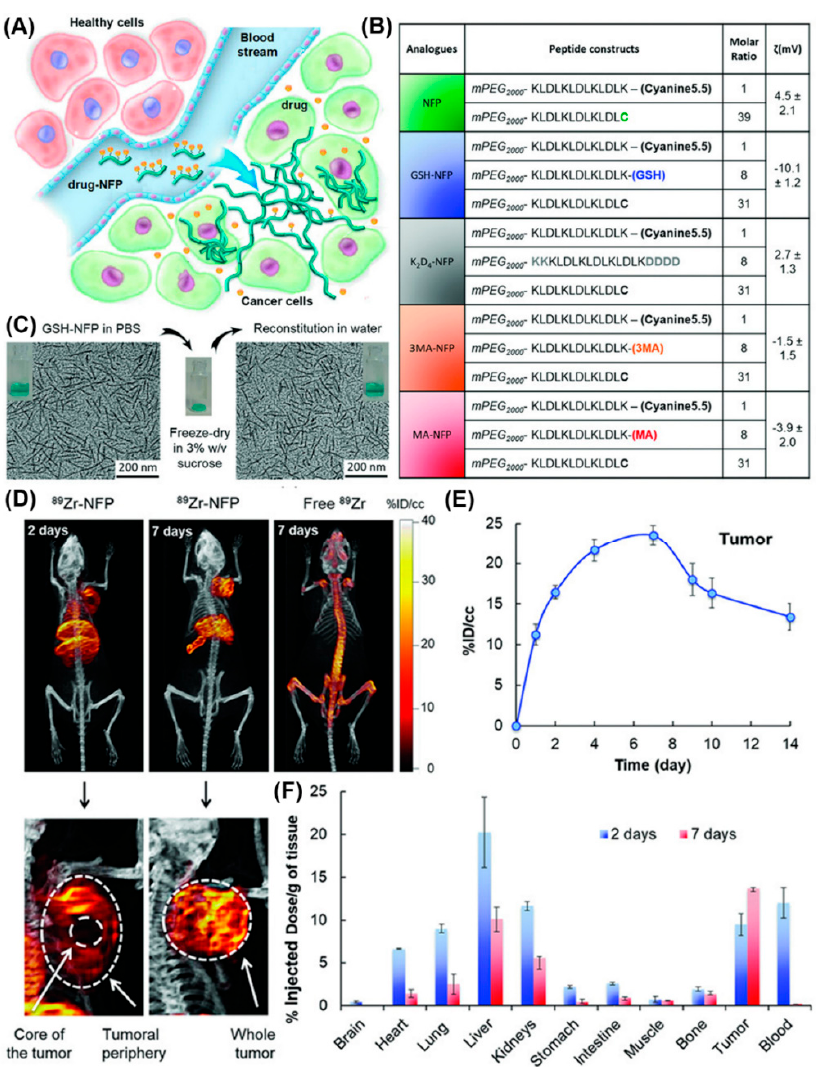
Figure 19. ( A ) Design of NFP analogues to improve tumoral uptake, penetration, and local retention. ( B ) A table showing NFP analogue composition and surface charge. ( C ) Morphologies of GSH-NFP in PBS buffer (left) before freeze-drying in sucrose and after reconstitution in water (right). ( D ) Representative PET/CT whole body images of SCID mice bearing MDA-MB-468 tumors were acquired 2 and 7 days after injection. ( E ) Quantification of nanofibers (radioactivity) at the region of interest (ROI; tumor) was plotted to reveal the kinetic uptake and the retention properties of GSH-NFP at tumor sites. ( F ) The biodistribution of 89 Zr-NFP was determined in separate groups of animals. Reproduced from [78], with permission. Copyright: 2018 John Wiley &